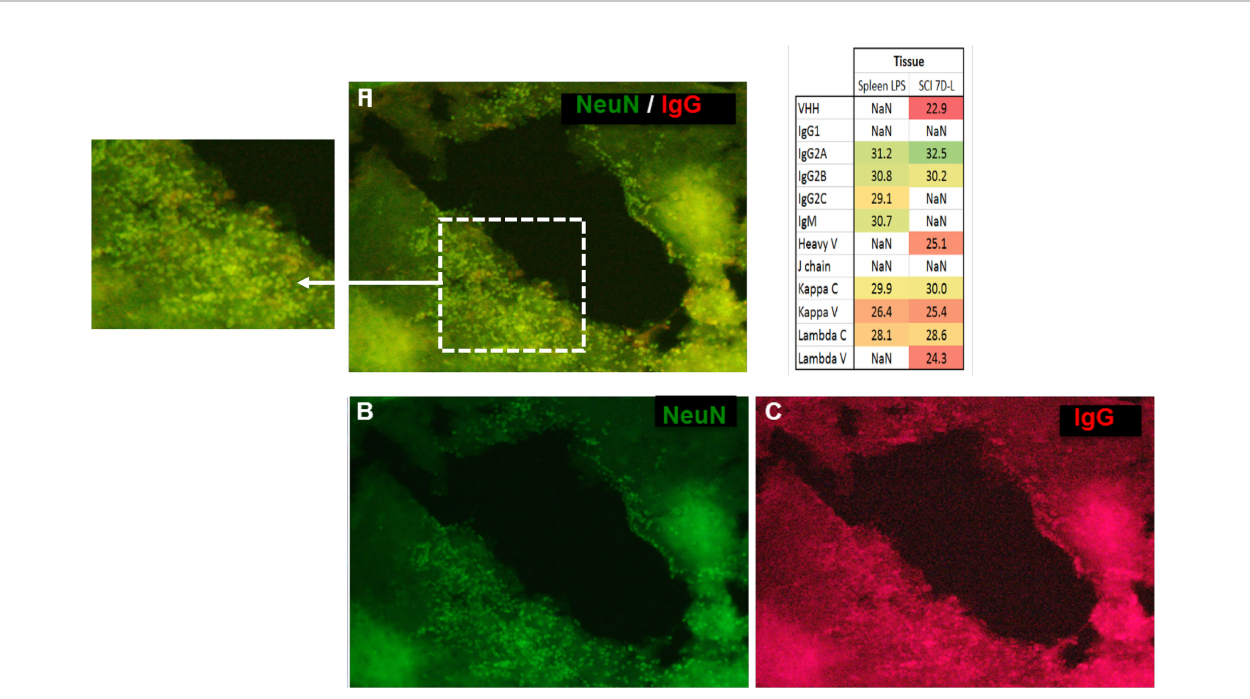
FIGURE 3 | The immuno fl uorescence performed on a section of lesion segment from the spinal cord revealed a colocalization (A) between NeuN ( (B) , green, Alexa Fluor® 488) and IgG ( C , red, Alexa Fluor® 647) (20X objective). Inset Table 4 . Sequence coverage in the SCI data from the different isotypes of immunoglobulins from SCI tissues at 7 days after lesion and spleen from rat stimulated with LPS as